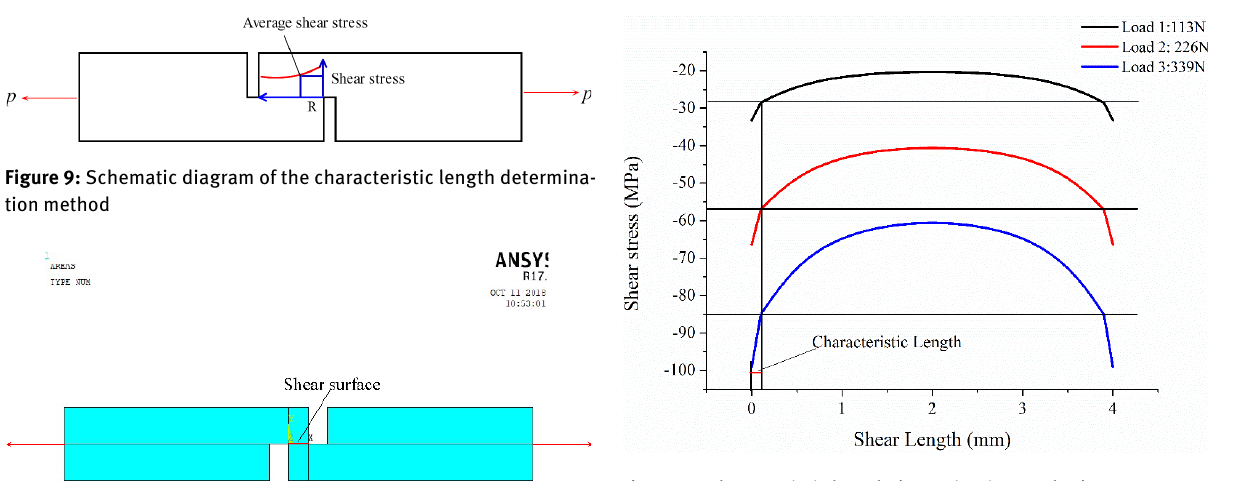
Figure 11: Characteristic length determination